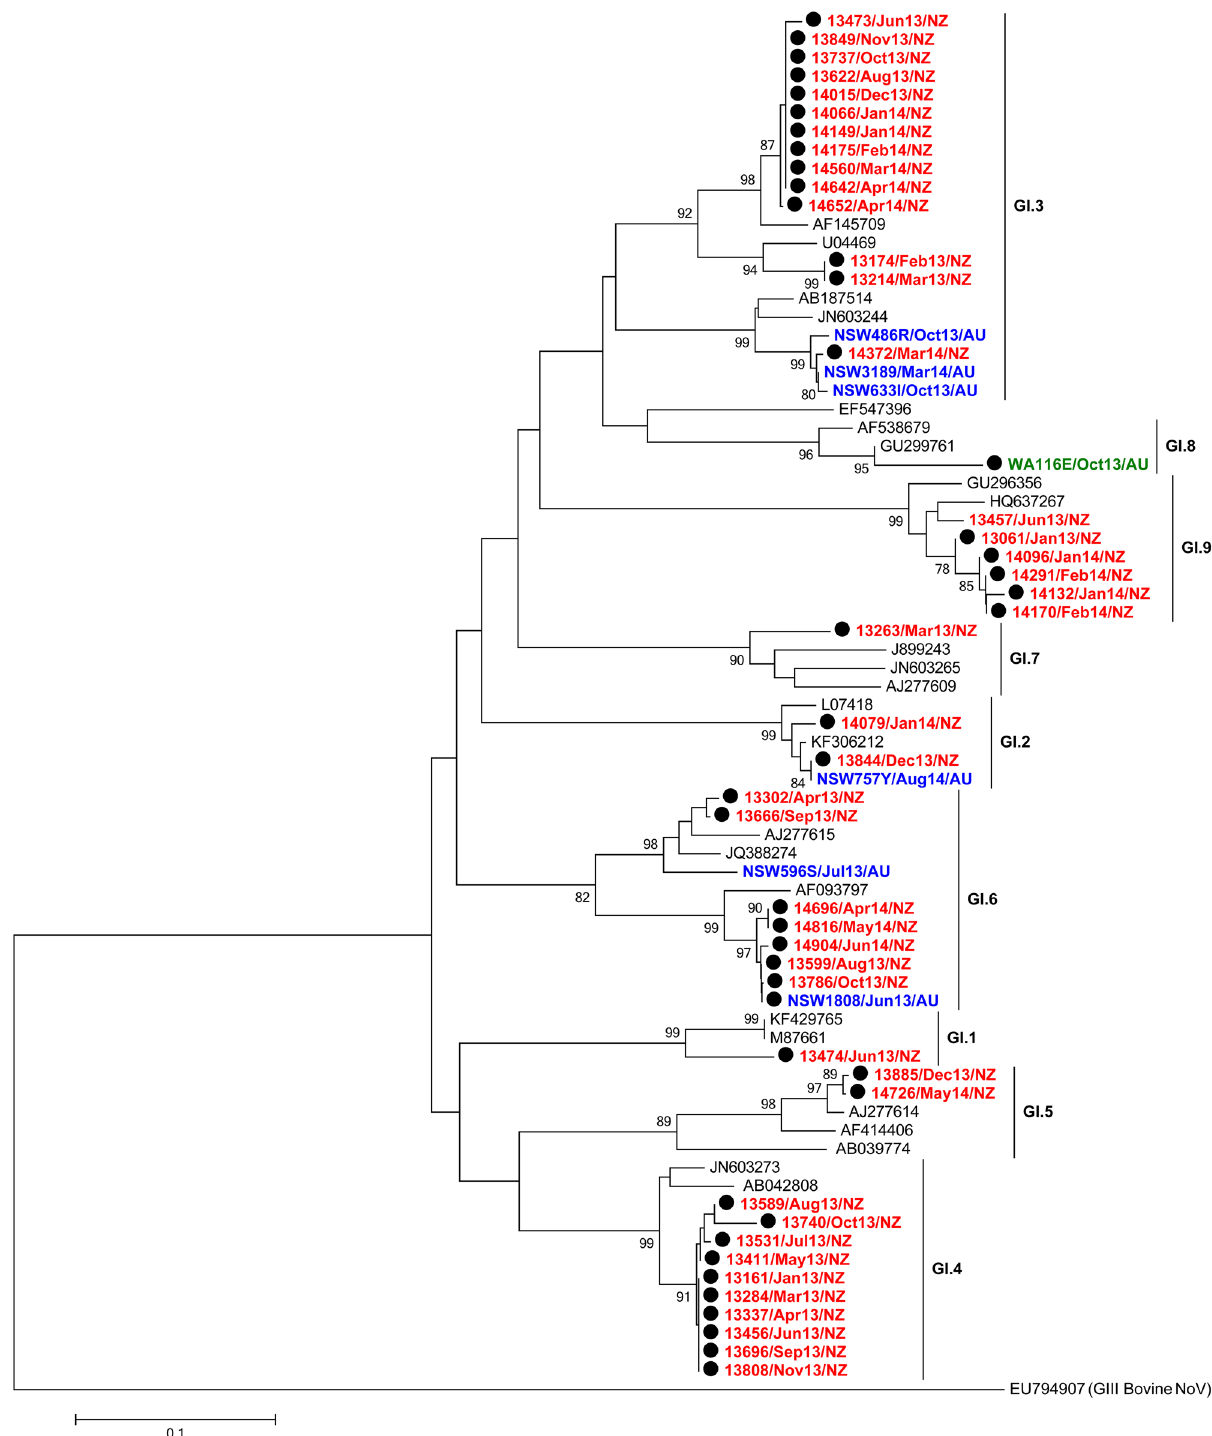
Fig 4. Phylogenetic analysis of NoV GI partial capsid nucleotide (nt) sequences. GI sequences (294 nt, nt position 5359 – 5652 with reference to Norwalk virus, GenBank accession number X87661) are shown in the neighbour-joining phylogeny of the 5 ’ end of ORF2. Global NoV reference sequences (n = 25) from GenBank are labelled in black while representative NoV sequences of this study (n = 50) are labelled in red (New Zealand), blue (NSW Australia) or green (WA Australia). Each NoV-associated outbreak is indicated with a black solid circle. The phylogeny was generated using programs within MEGA 5, with bootstrap values of (cid:1) 75 indicated as a percentage of 1000 replicates.